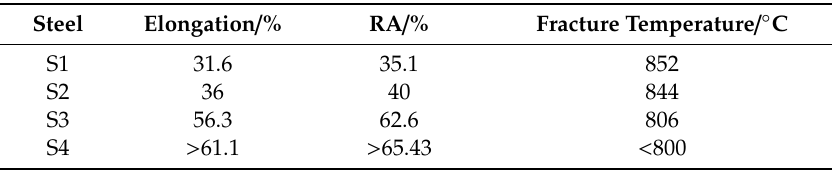
Table 3. Results of the hot tensile